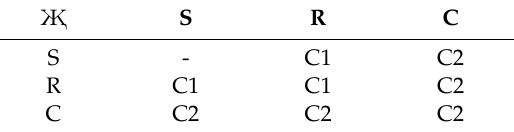
Table 21. Risk classification truth table.